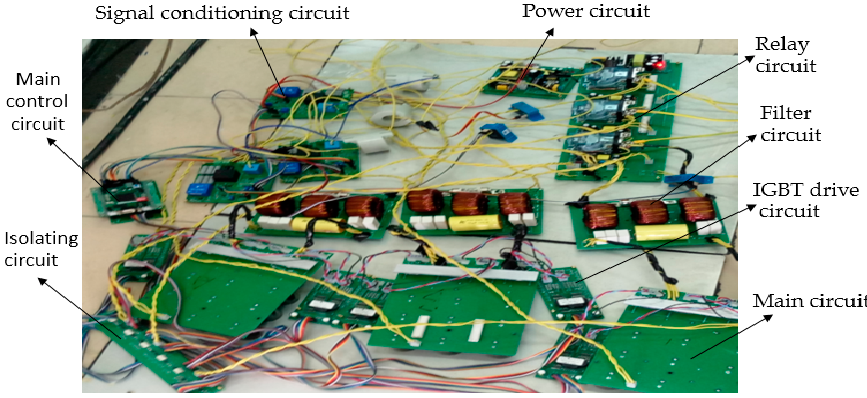
Figure 13. Hardware of the PAPF in the UPQC.